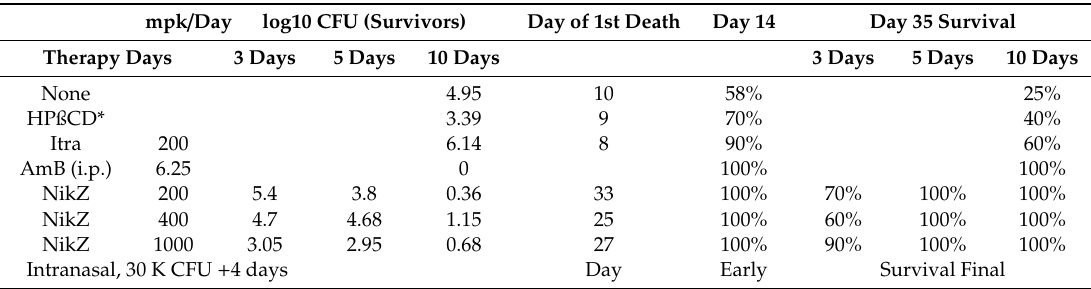
Table 8. pulmonary blastomycosis: organ burden (log 10 CFU lung); day of first death (none in AmB or NikZ ≥ 5 day), Survival as of Day 14 (10 day groups, 1 day post therapy), Survival as of final day 35. HPßCD* is carrier vehicle for Itra administration